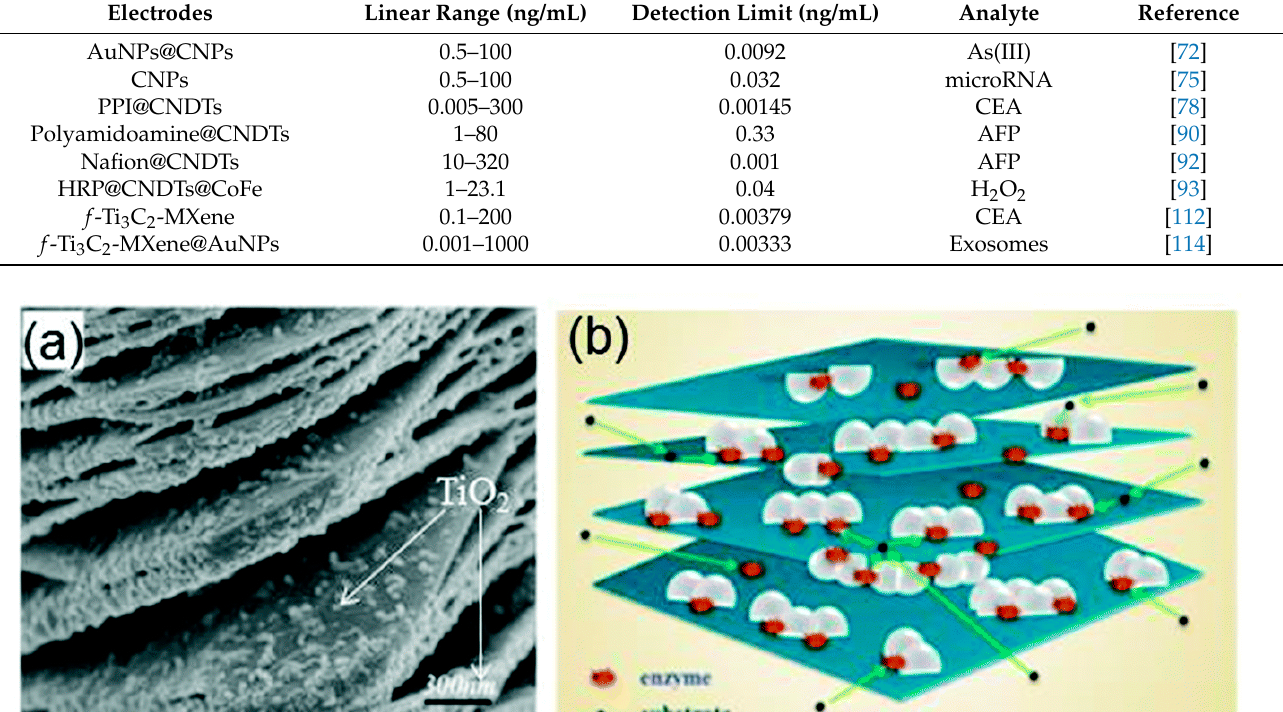
Figure 10. ( a ) SEM image of the TiO 2 -Ti 3 C 2 nanocomposite. ( b ) Graphics of the TiO 2 -Ti 3 C 2 nanocom- posite. Reproduced with authorisation from Refs. [105,115]. Copyright of Elsevier and Royal Society of Chemistry (RSC).